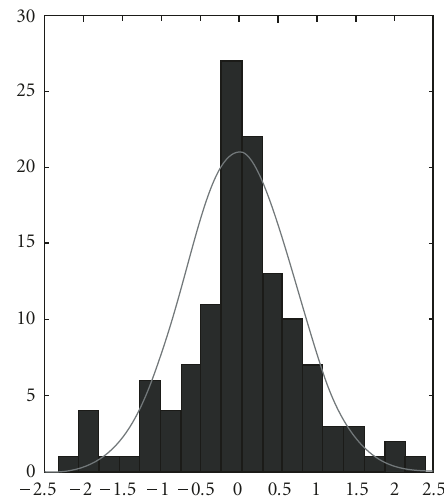
Figure 3: Normalized repartition of the projections of another codebook along its principal axis.